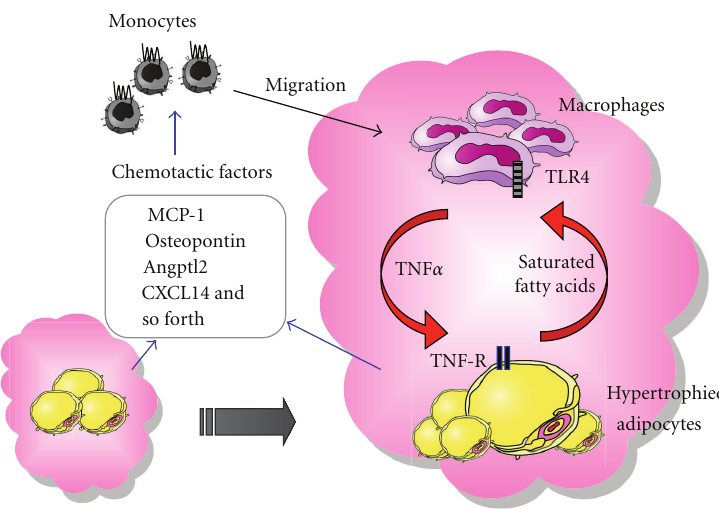
Figure 2: Molecular mechanism underlying adipose tissue inflammation. During the course of obesity, adipose tissue secretes several chemotactic factors to induce macrophage infiltration into adipose tissue. Circulating monocytes migrate and infiltrate into adipose tissue through adhesion process to endothelial cells. Macrophages enhance the inflammatory changes through the crosstalk with parenchymal adipocytes. For example, the macrophage-derived tumor necrosis factor- α (TNF α ) induces the release of saturated fatty acids from adipocytes via lipolysis, which, in turn, induces inflammatory changes in macrophages via TLR4. Such a paracrine loop between adipocytes and macrophages constitutes a vicious cycle, thereby further accelerating adipose tissue inflammation. TNF-R, TNF α